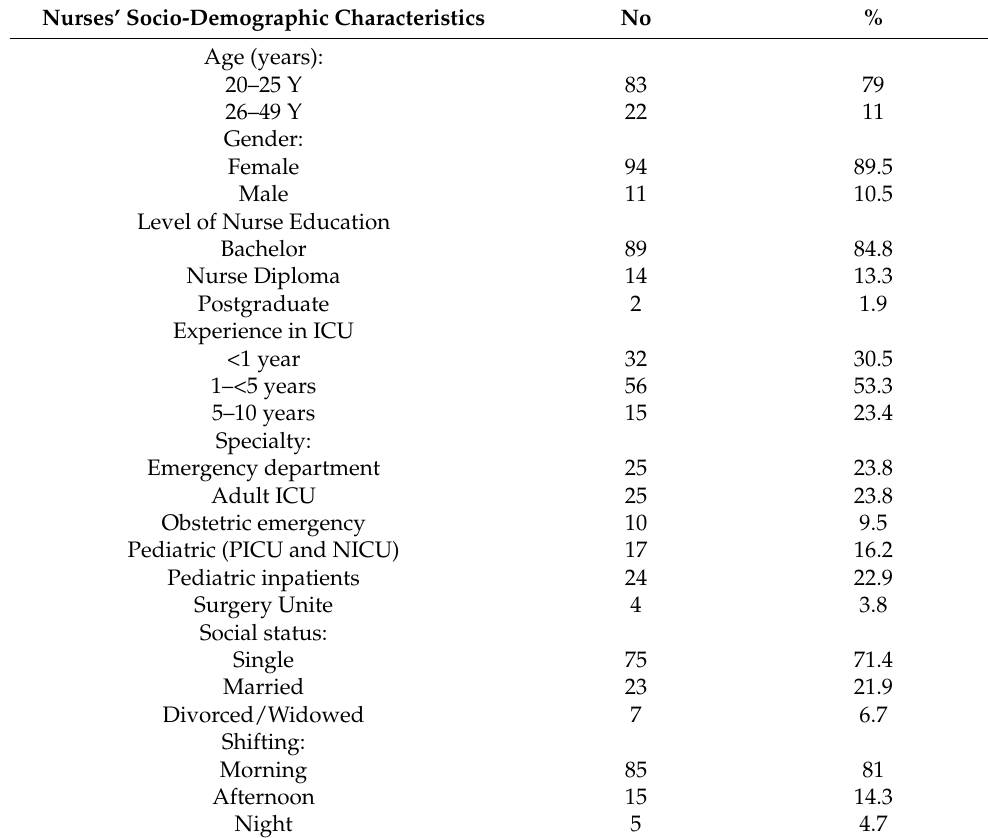
Table 1. Distribution of studied subjects in relation to socio-demographic and work characteristics (N = 105).